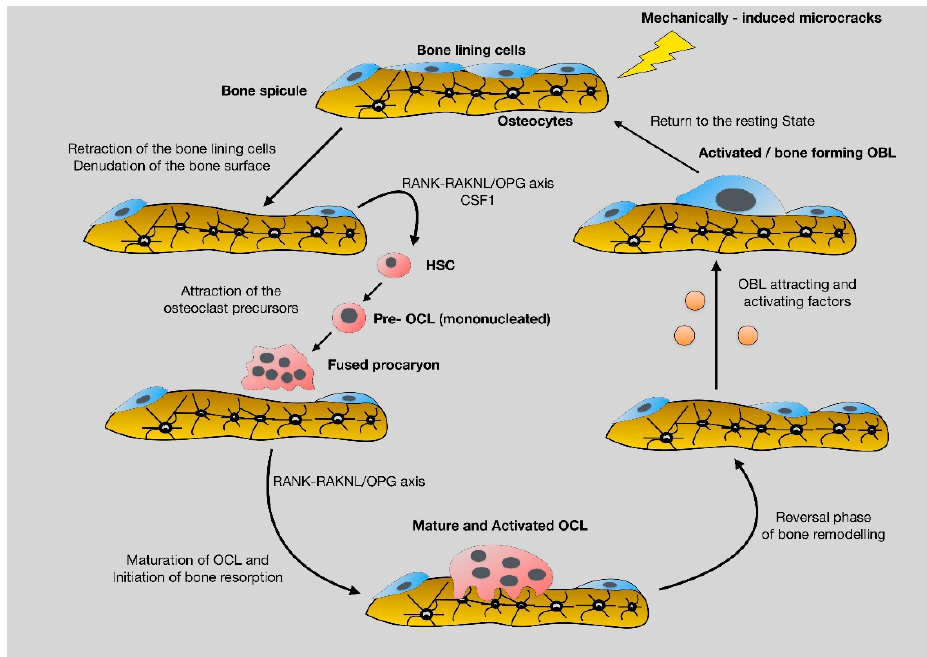
Figure 1. Schematic presentation of the cellular and molecular events that characterize bone remodeling. Briefly, microfractures that take place during every day normal activities activate the mechanoresponsive osteocytes, which in turn, through their cytoplasmic projections, send signals to bone lining cells that are retracted, leaving free space on bone surfaces for osteoclasts. Pro-osteoclasts are attracted to this denuded area and differentiate to mature and active multinucleate osteoclast that start bone resorption. During bone degradation osteoblast attracting molecules, such TGF beta are released, leading to diffraction and activation of osteoblasts that reach the resorbed area and start to synthesize new bone. The circle is repeated continuously, according to the applied mechanically forces. Disturbances in the well-balanced circle of bone remodeling result in bone pathologies, including inadequate fracture-healing.